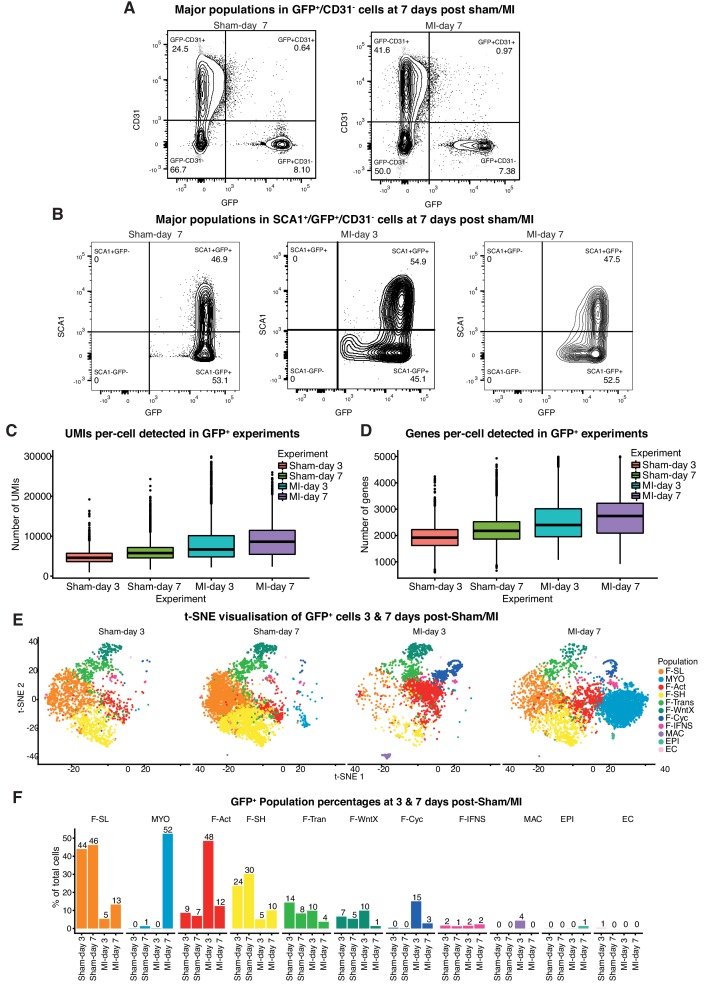
FACS profiles and scRNA-seq analysis for GFP+/CD31- cells.(A) FACS plots and gating strategies for sorting GFP+/CD31- population at 7 days post-sham or MI surgery. (B) FACS plots showing SCA1 expression profiles in GFP+/CD31- cells at 7 days post-sham or MI surgery. (C) Boxplot showing number of UMIs detected per-cell across experimental conditions in GFP+/CD31- fraction after quality control filtering. (D) Boxplot showing number of genes detected per-cell across experimental conditions in GFP+/CD31- fraction after quality control filtering. (E) t-SNE visualization of scRNA-seq clusters for all sham and MI time-points in GFP+/CD31- cells. (F) Cell population proportions across all experimental conditions.